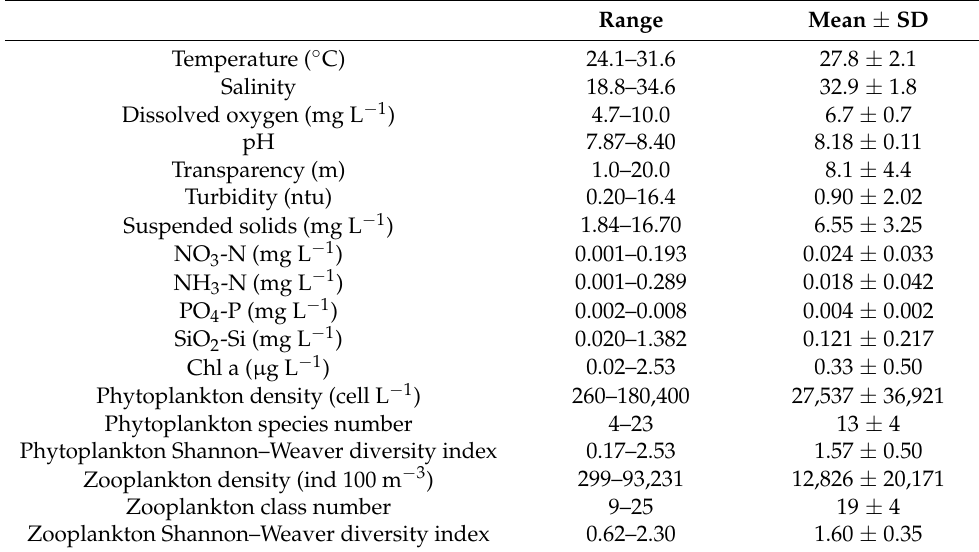
Table 1. Ranges and means ( ± SD) of the hydrological and biological variables in the study area from 2011 to 2014 (N = 96).